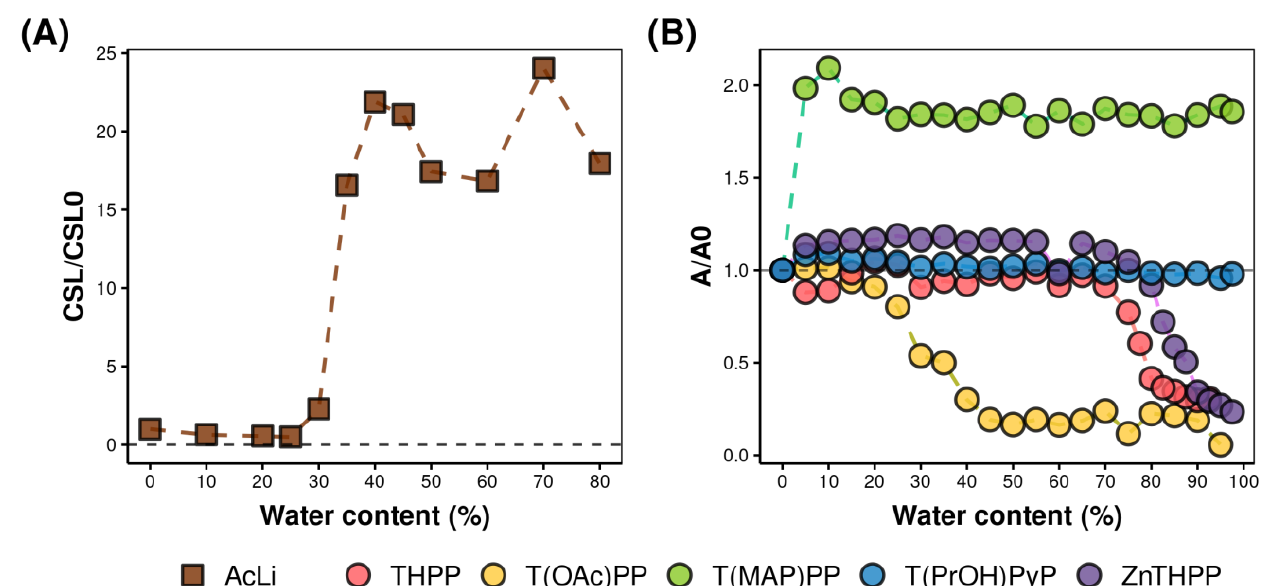
Figure 2. Simulation of nanoparticles formation. ( A ) Corrected scattered light (CSL) of an acetylated lignin solution (acetone, 2 mg/mL) as a function of water addition. ( B ) Porphyrin aggregation as a function of water addition. Porphyrins were dissolved in the organic solvent or solvents mixture used as the starting solution for nanoparticles formation, at a final concentration of 5 µM. Porphyrin aggregation was monitored through the maximum absorbance of the Soret band in their respective solvent: THPP , acetone; T ( OAc ) PP , acetone:DMF 9:1; T ( MAP ) PP , acetone:DMSO; T ( PrOH ) PyP , acetone:DMSO 9:1; ZnTHPP , THF.